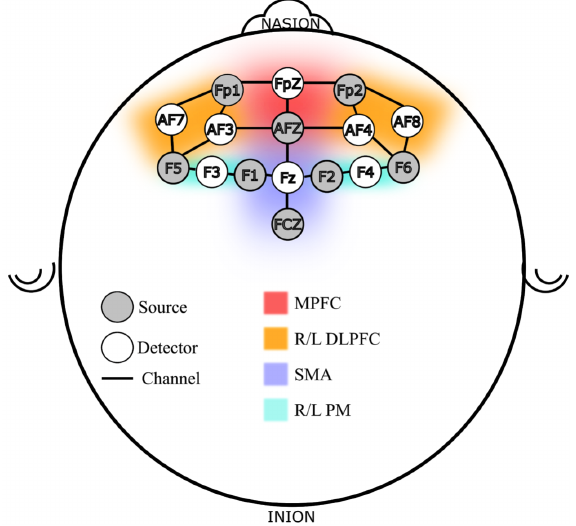
Figure 2. fNIRS Probe Map Design, Channels and Regions of Interest